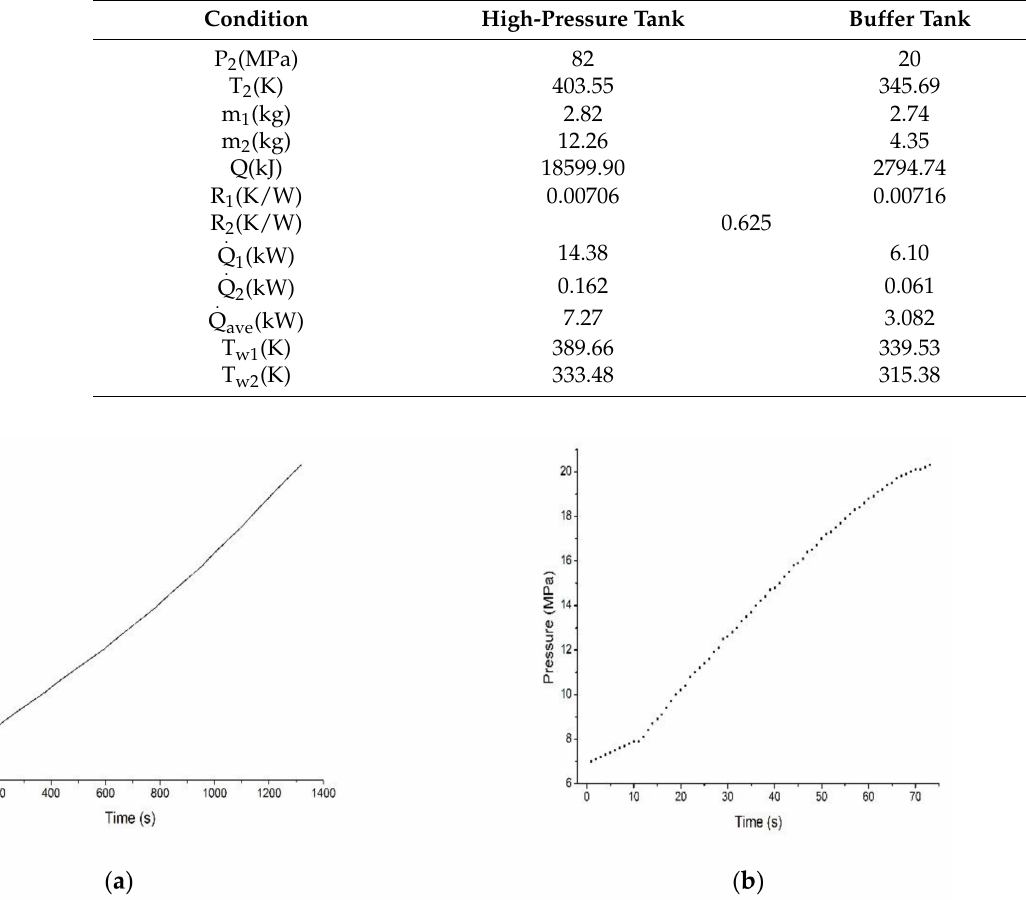
Figure 9. The experimental results of the pressure measurement over time. ( a ) The pressure value of the high-pressure tank for the second cycle; ( b ) pressure value of the buffer tank for the second cycle.